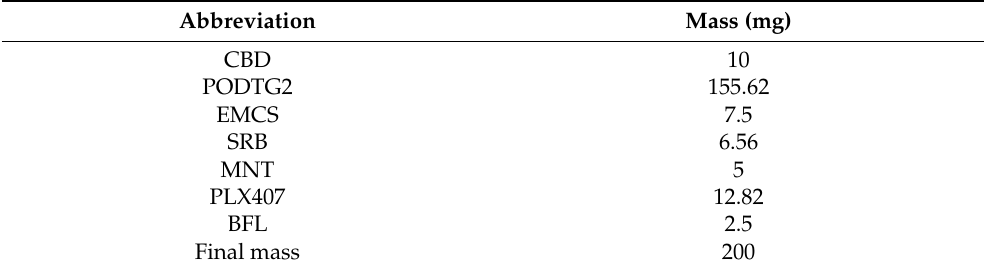
Table 8. The composition of the optimal